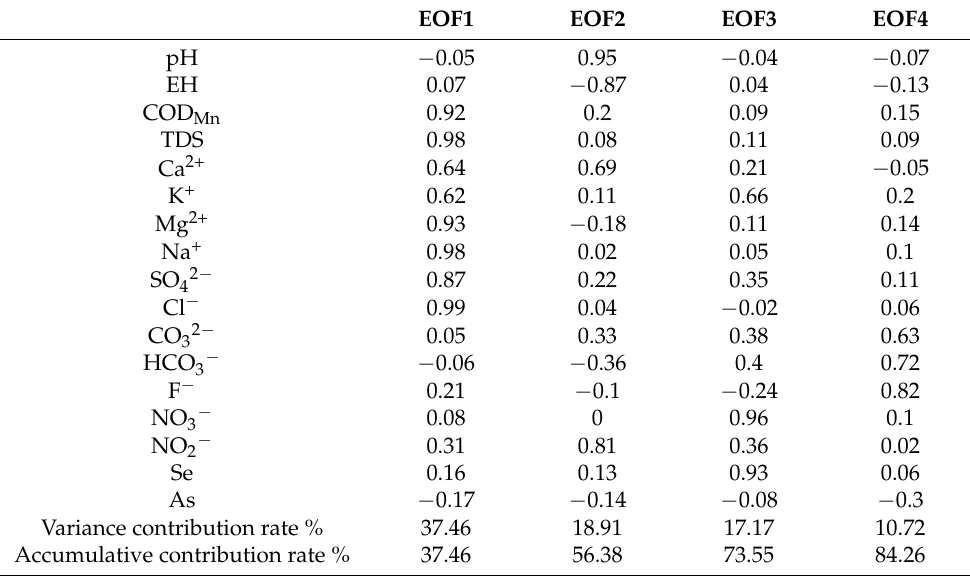
Table 2. Loading matrix for the hydrochemical constituent factor analysis of the research